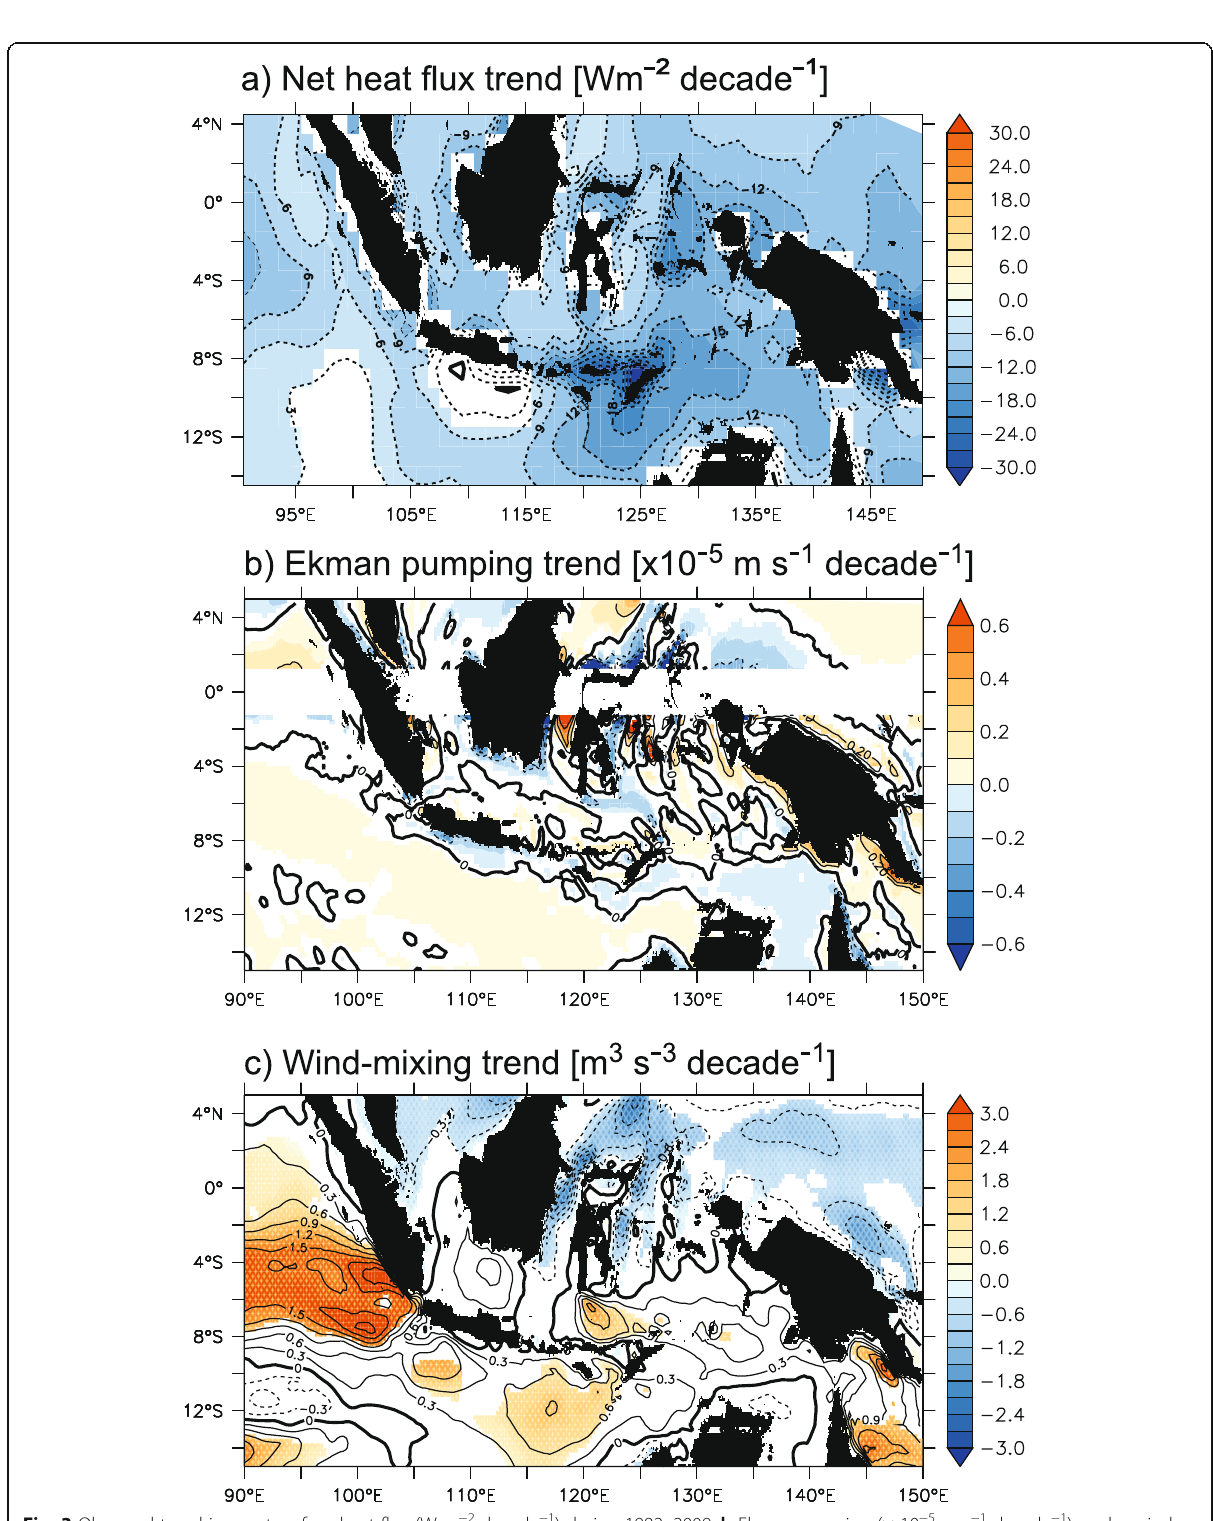
Fig. 3 Observed trend in a net surface heat flux (W m − 2 decade − 1 ) during 1982 – 2009, b Ekman pumping (× 10 − 5 m s − 1 decade − 1 ), and c wind induced-mixing (m − 3 s − 3 decade − 1 ) during 1982 – 2014. Significant values above 95% confidence level are